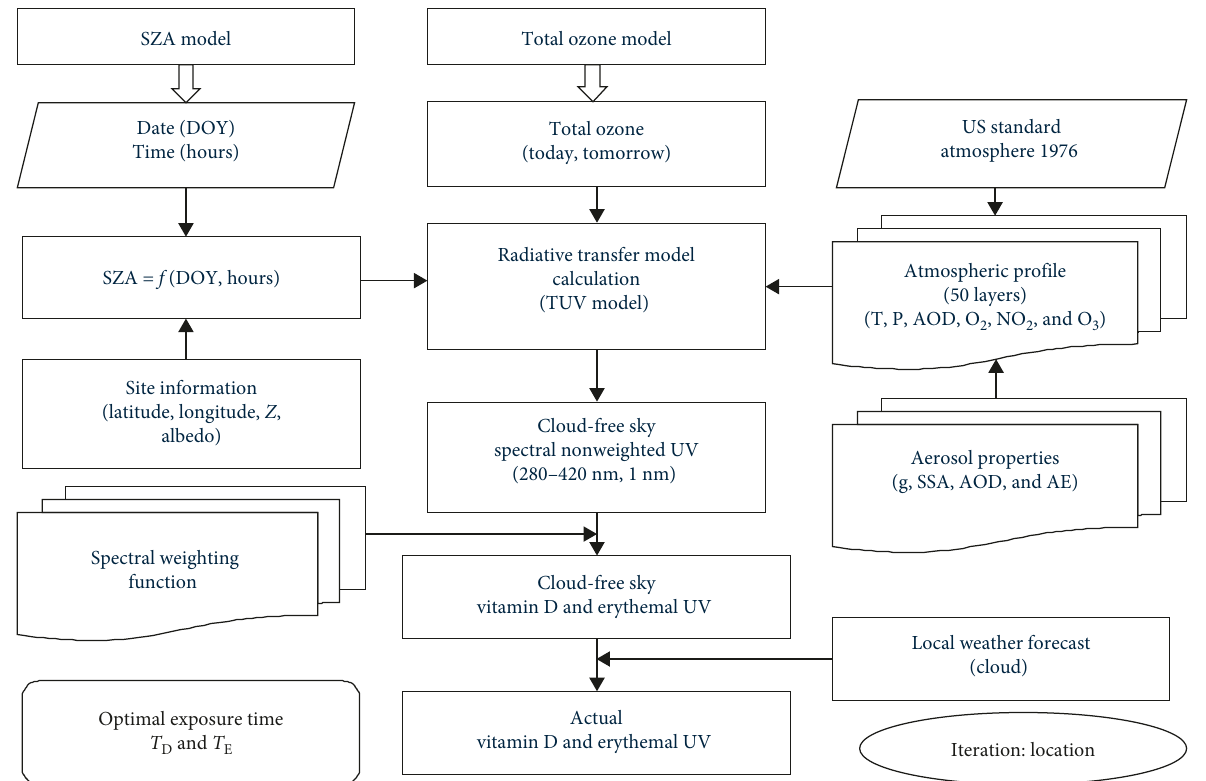
Figure 1: Flow chart of forecast system of exposure time for vitamin D